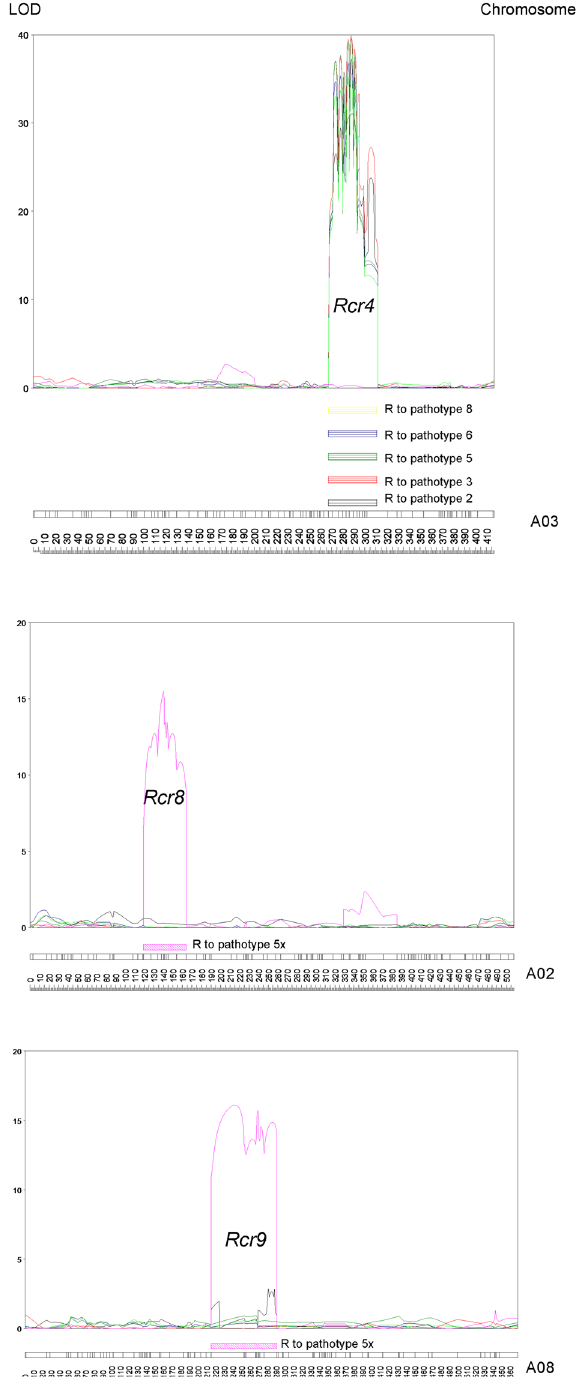
Figure 4. Three significant QTL of Rcr4 , Rcr7 and Rcr8 detected chromosomes on A03, A02 and A08, peak position at 282.65 cM. The SNP site nearest the peak for Rcr4 was at SNP site A03_23710236 (chromosome_ physical location) with LOD values of 30.3 to 38.8 for the five pathotypes, and phenotypic variation explained (PVE) 85% to 94% (Table 3). Two QTLs, designated Rcr8 and Rcr9 , were detected on chromosomes A02 and A08, respectively, for resistance to pathotype 5x. Rcr8 spanned from 126.91 to 164.4 cM, with a peak position at 139.8 cM. The SNP site nearest the peak for Rcr8 was at SNP site A02_18552018 (15 LOD), with PVE of 36%. Rcr9 spanned from 214.61 to 291.25 cM, with a peak position at 242.5 cM. The SNP site nearest the peak for Rcr9 was